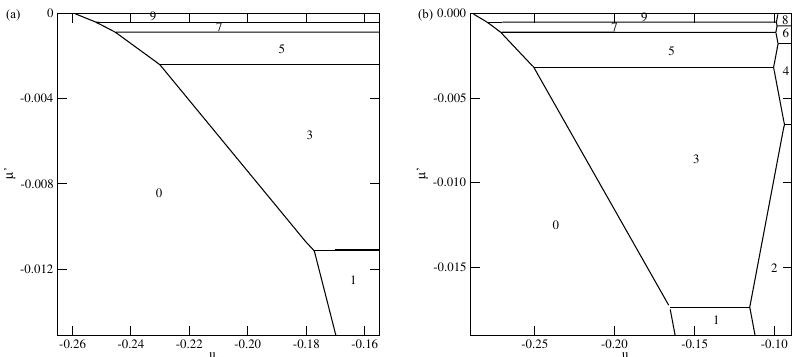
Figure 9. The ground state phase diagrams for the systems with V A = − 0.6 and V B = 0.0 ( a panel) and with V A = − 0.6 and V B = − 0.1 ( b panel). The numbers mark the numbers of layers stable in different regions.